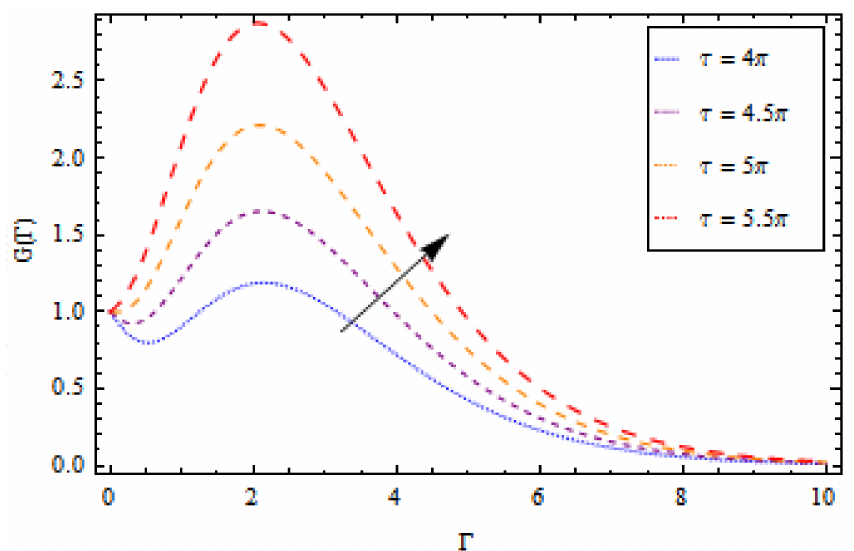
Figure 13. Impact of τ on temperature profile G ( Γ ) , when Pr = 0.5, Rd = 0.5, K = 0.5, κ = 0.5, γ = 0.5, λ = 0.5, A = 0.5.